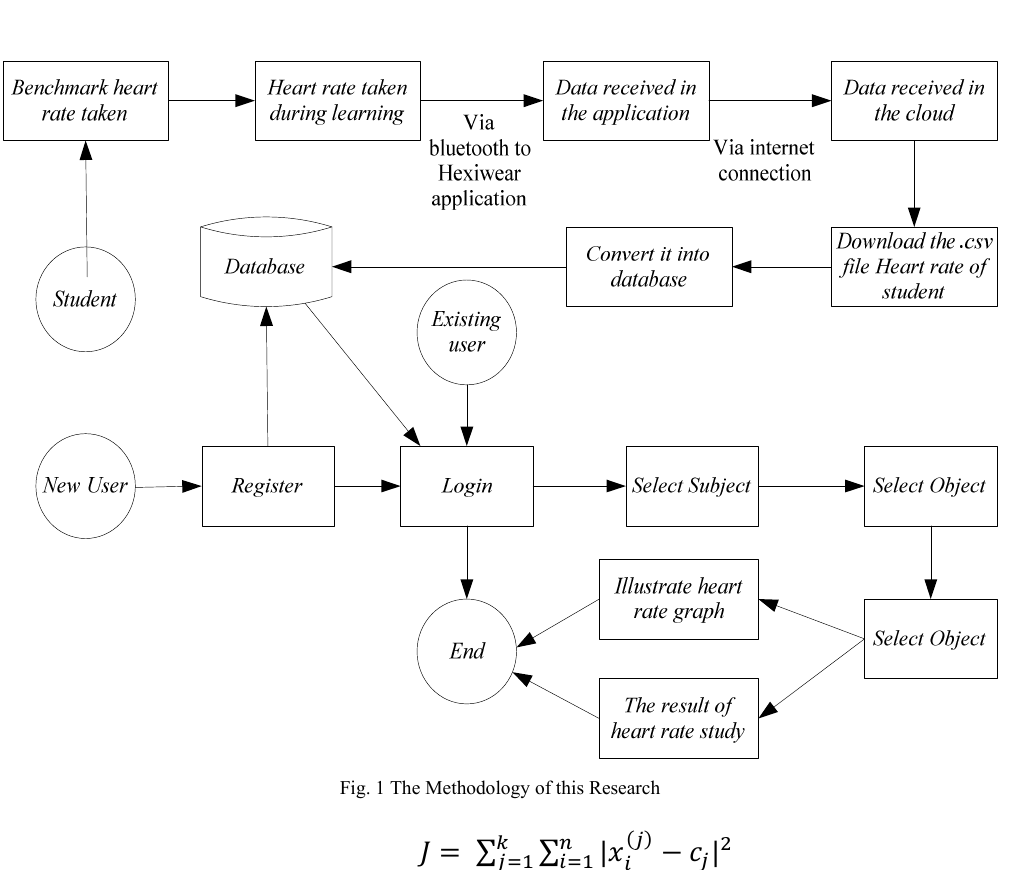
Fig. 1 The Methodology of this Research